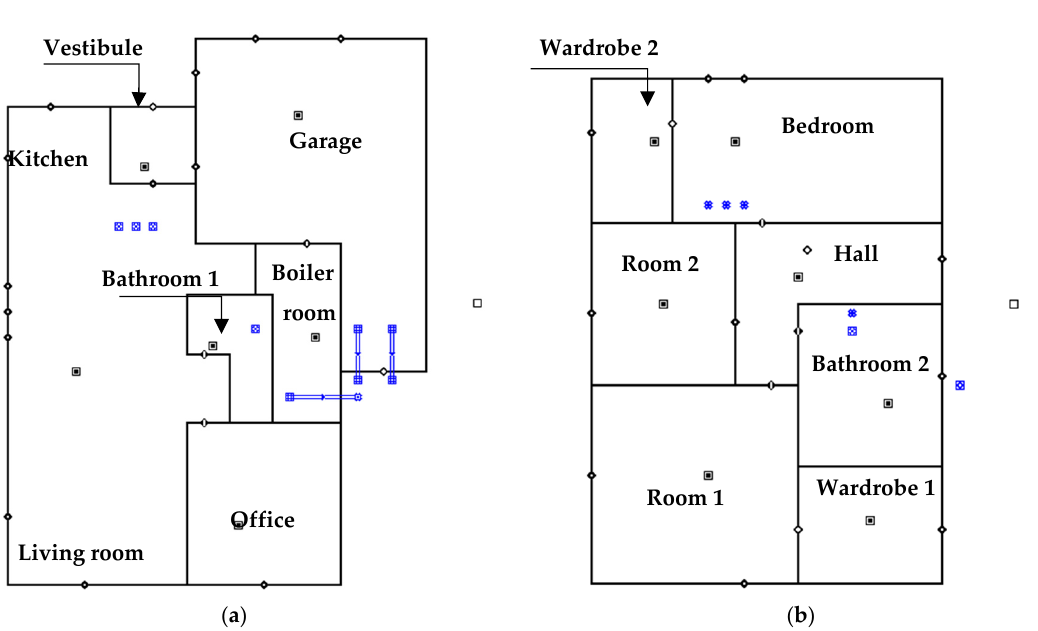
Figure 3. View of 2 stories in building for the Contam model: ( a ) ground floor; ( b ) usable attic. Ventilation ducts are indicated in blue.